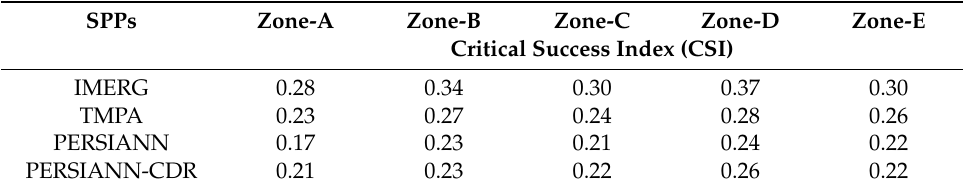
Table 3. The average CSI of SPPs over the five climate zones.